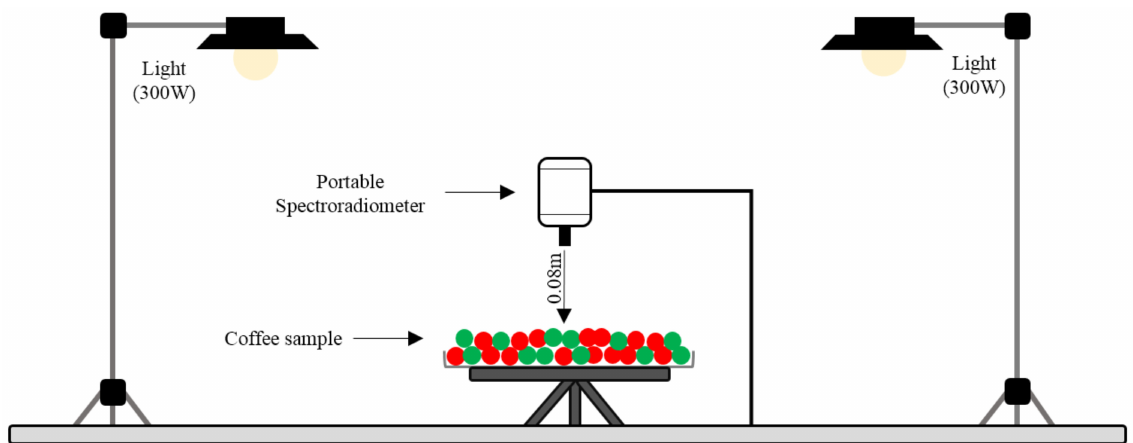
Figure 4. Laboratory experiment set up used to characterize the spectra of the coffee fruit ripeness. Table 3. References and equations of the spectral vegetation indices evaluated in this study. Vegetation Index Equation Reference